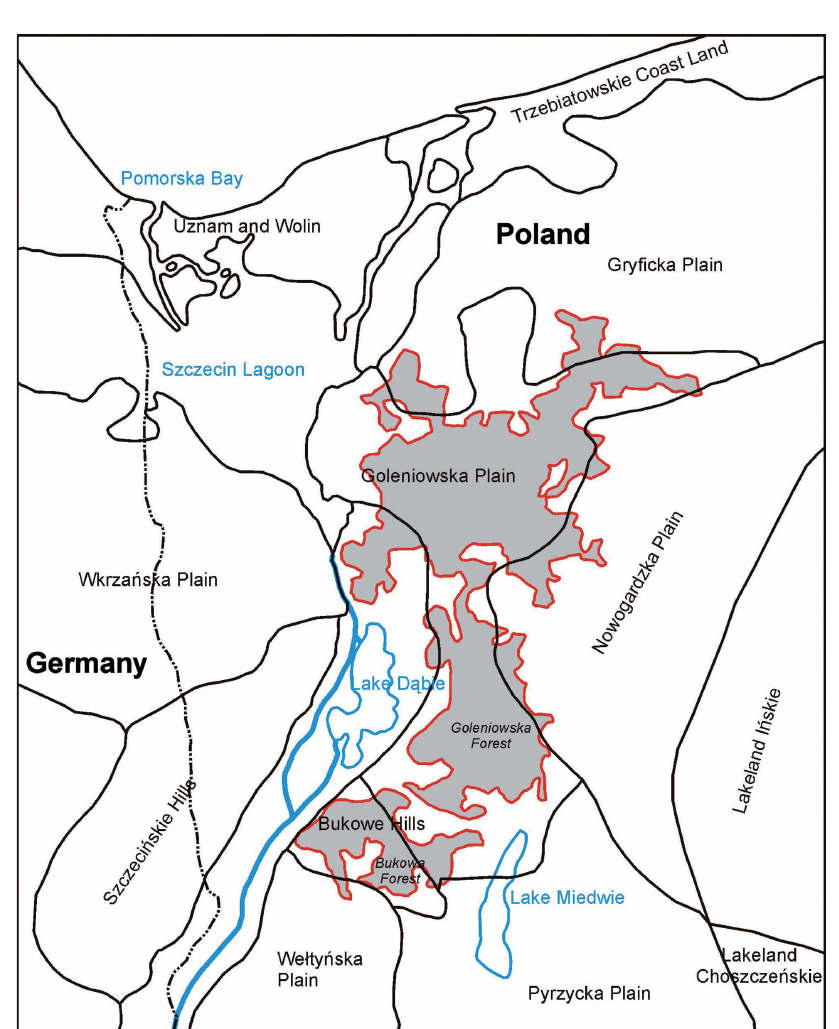
Fig. 1. The location of Goleniowska Forest and Bukowska Forest superimposed against a regional division of Poland (Kon- dracki 2009,